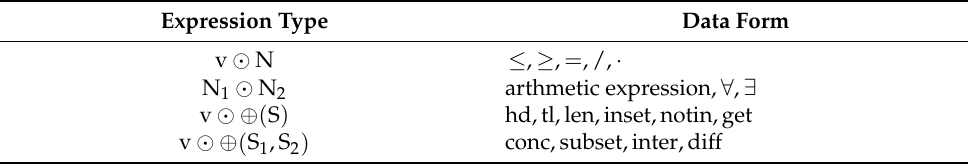
Table 4. Variable types and expressions.